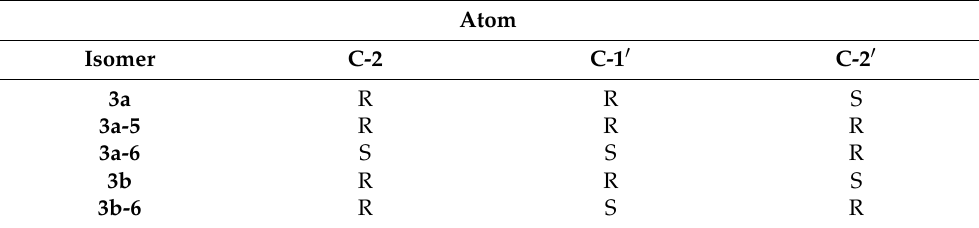
Table 1. Relative configurations at atoms C-2, C-1 (cid:48) and C-2 (cid:48) of bioactive macrozone stereoisomers. Atom Isomer C-2 C-1 (cid:48) C-2